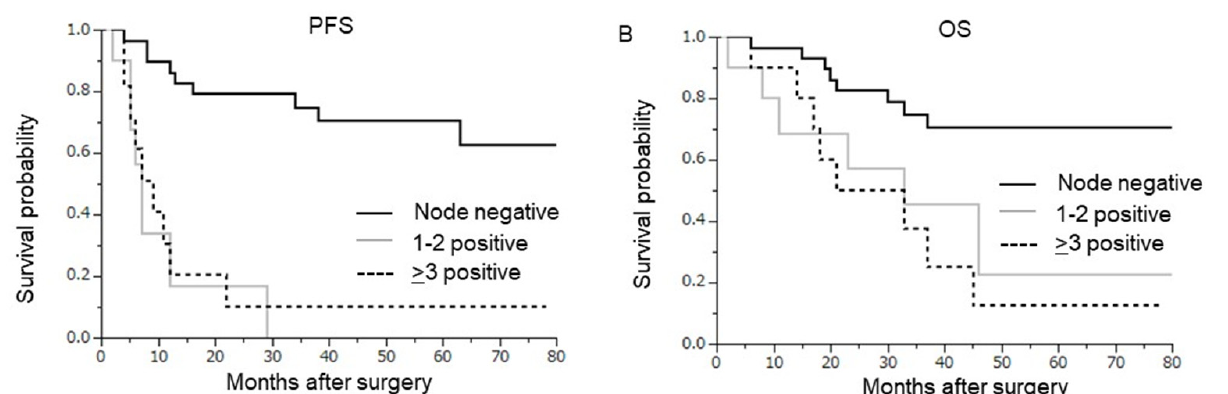
Of the 21 patients with lymph node metastasis, 10 had 1–2 positive nodes and 11 had ≥ 3 positive nodes (Table 1). A comparison of the clinicopathological characteristics between the two groups (1–2 vs. ≥ 3 node metastases) revealed no significant differences in patient characteristics, except for tumor histology, parametrial invasion, surgical margins, and stromal invasion (Supplemental Table S3). As shown in Figure 2, the survival of patients with ≥ 3 node metastases ( ≥ 3) was equivalent to that of patients with 1–2 node metastases (PFS, p = 0.7736; OS, p = 0.5229).